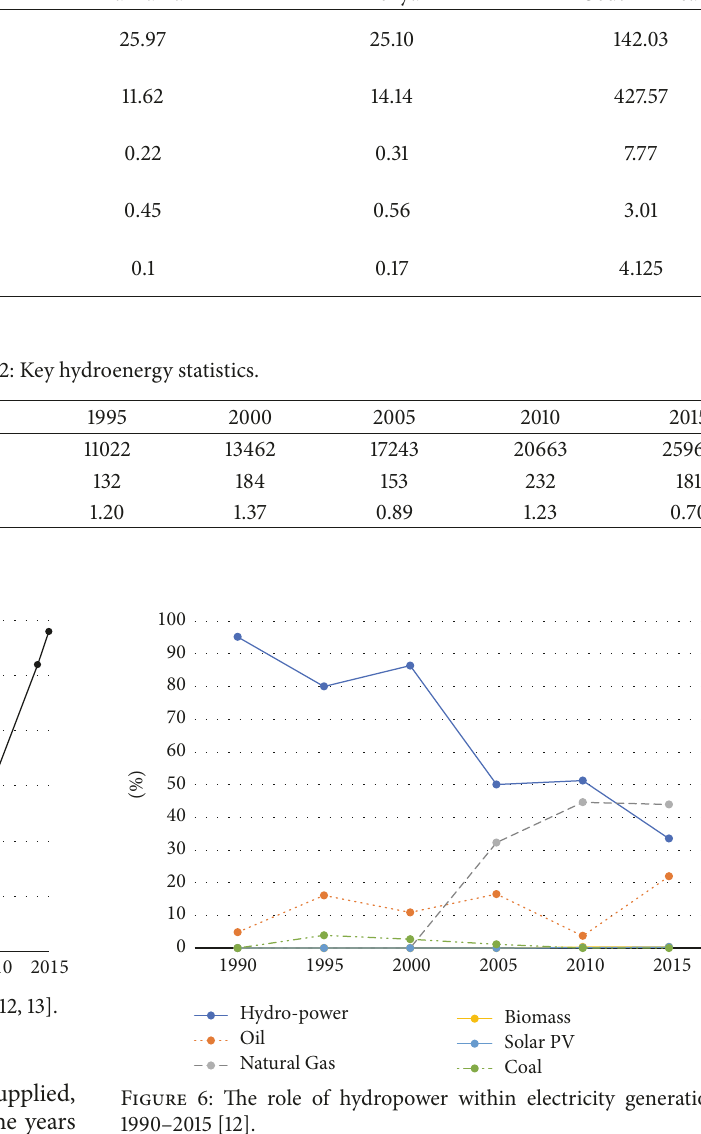
Figure 6. Over the period from 1990 to 2015,